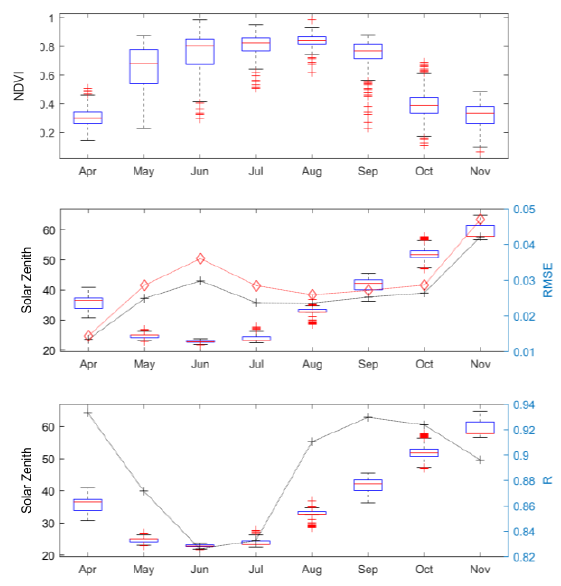
Figure 4. The impact of phenological phases on the accuracy of MCD43A1